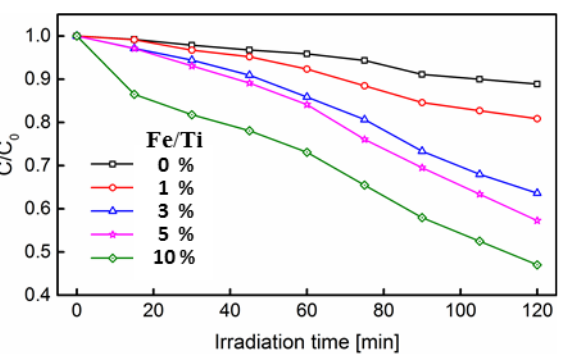
Figure 15. Absorption spectra of Rh-B dye in the existence of the Fe/Ti = 10% sample at various irradiation times.